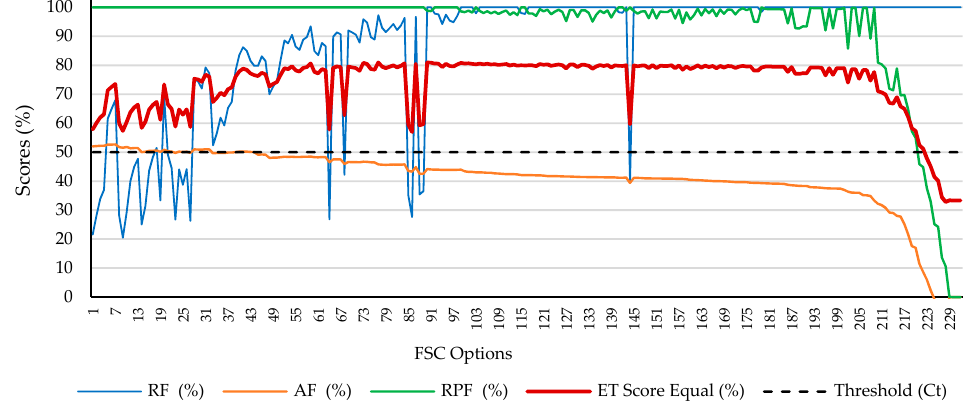
Figure 11. Graphical presentation of all FSCs that satisfy the load demand at 14.2 kWh/day.